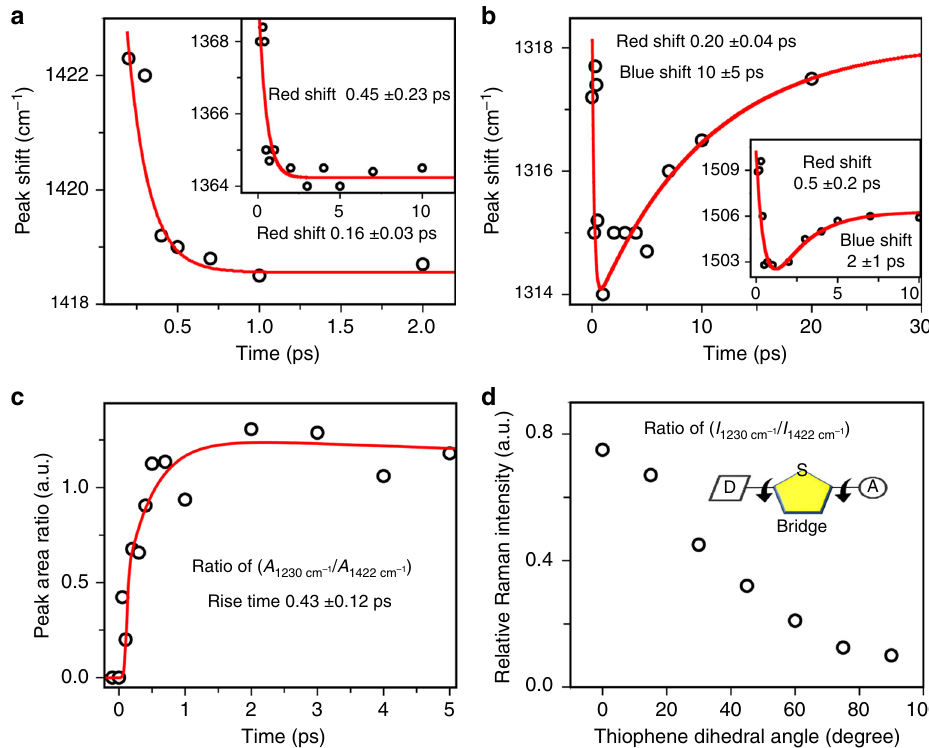
Fig. 5 Transient changes in the Raman peak frequency and area. a Peak shift of 1422 and 1367 cm − 1 mode (Inset) in about 160 and 450 fs timescale respectively; both the modes re fl ect red shifted spectra. b Peak shift of 1315 and 1503 cm − 1 mode (inset). The 1315 cm − 1 mode is red shifted in 200 fs and then blue shifted in 10 ps while 1503 cm − 1 mode shows blue shift in 2 ps. c Relative peak area changes of 1228 cm − 1 with respect to 1422 cm − 1 mode occur in 430 fs timescale. d Relative Raman intensity change of 1228 cm − 1 as a function of thiophene dihedral angle as obtained from DFT